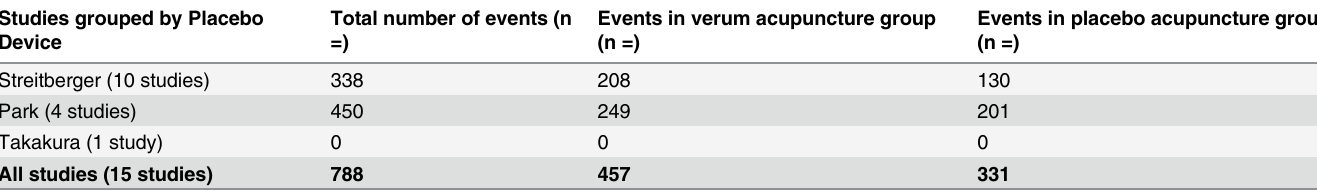
Table 5. Summary of adverse events reported by